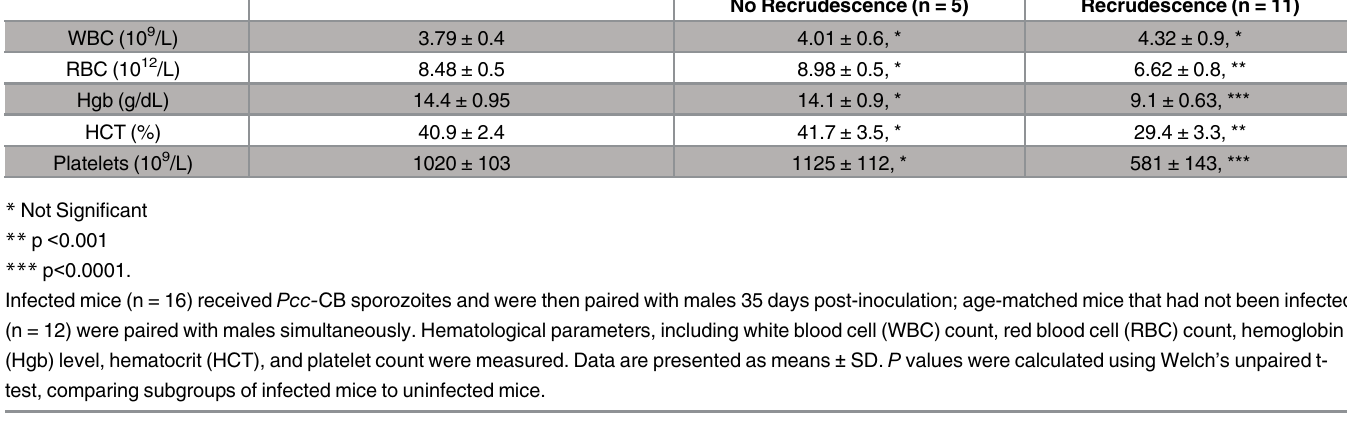
Table 1. Hematological profiles of infected and uninfected mice at gestational day 18.